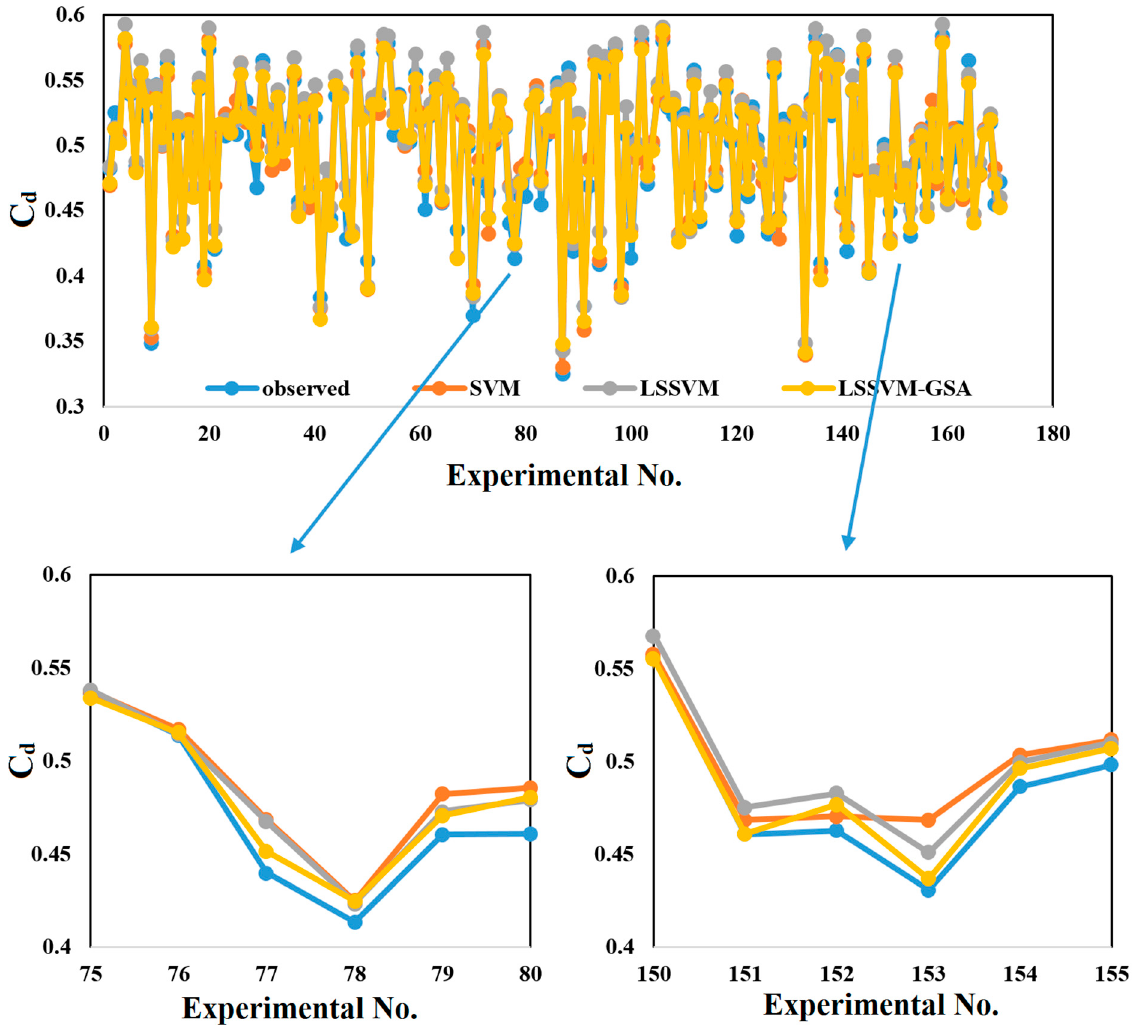
Figure 5. Observed and predicted C d of the implemented models for the best input combination in the test period.